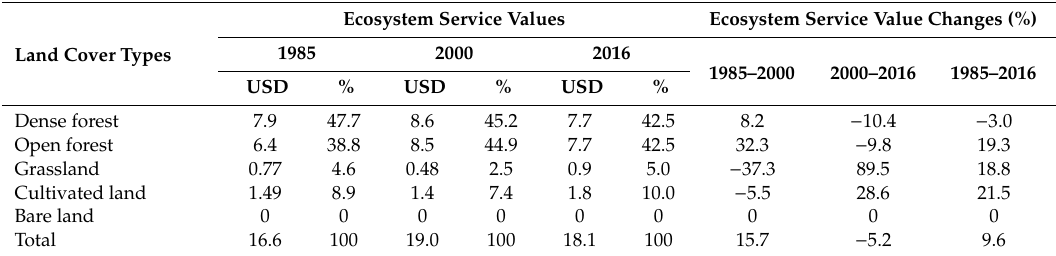
Table 5. Estimated ecosystem service values and dynamics for each land cover type of the di ff erent reference years and periods in million USD per year of the study